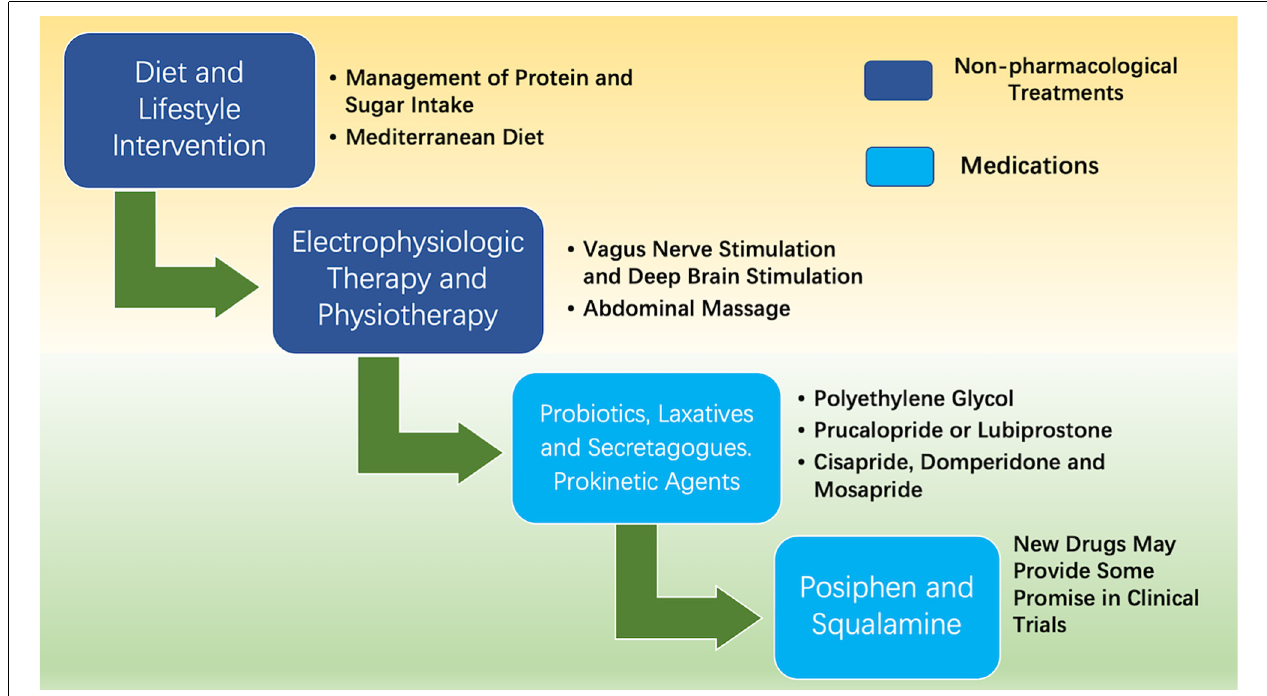
FIGURE 2 | Treatments of constipation in PD. The treatments for PD patients with complicated constipation include diet control, electrophysiologic therapy, physiotherapy, and